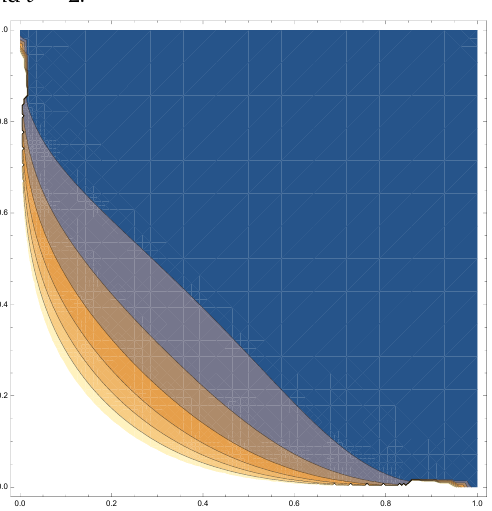
Figure A1. The bivariate Kumaraswamy density (Equation (1)) plot, where α = 0.5, β = 0.5, θ = 0.5 and δ = 2.